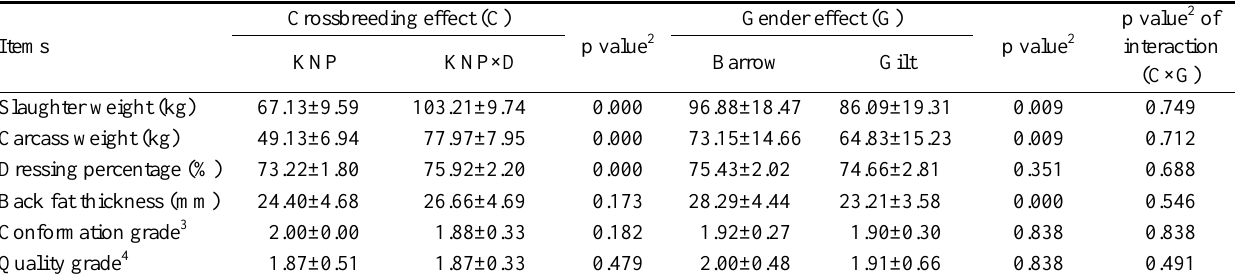
Table 1. Carcass traits 1 of Korean Native Black Pig and its crossbred with Duroc pig